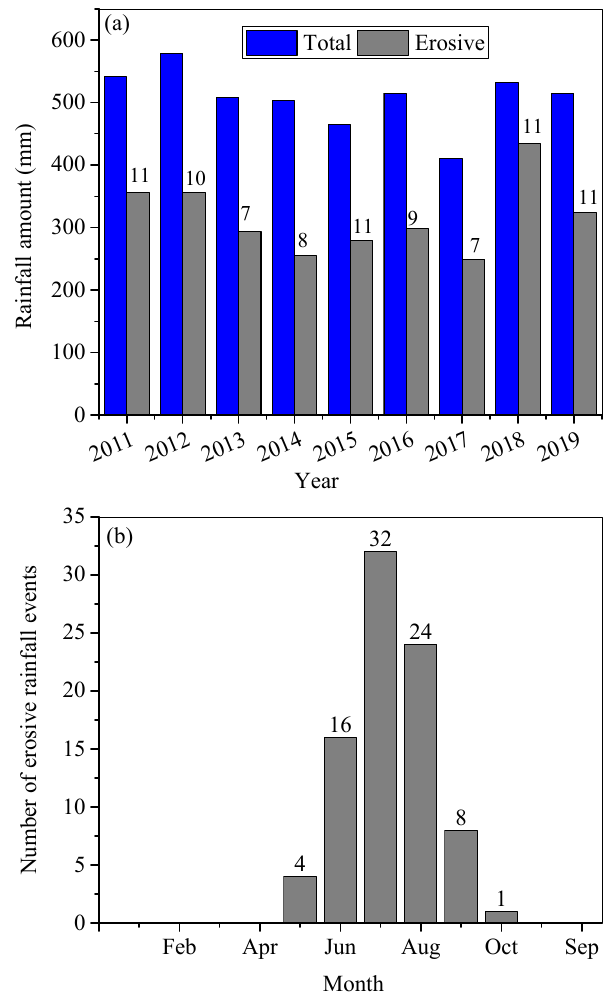
Figure 2. Annual total amount of rainfall and erosive rainfall between 2011–2019 ( a ). The number of erosive rainfall events in each month of the study period ( b ). The numbers on the erosive rainfall amount bars indicate the number of erosive rainfall events. Table 3. One-way analysis of variance (ANOVA) results using a K-means clustering classification method.